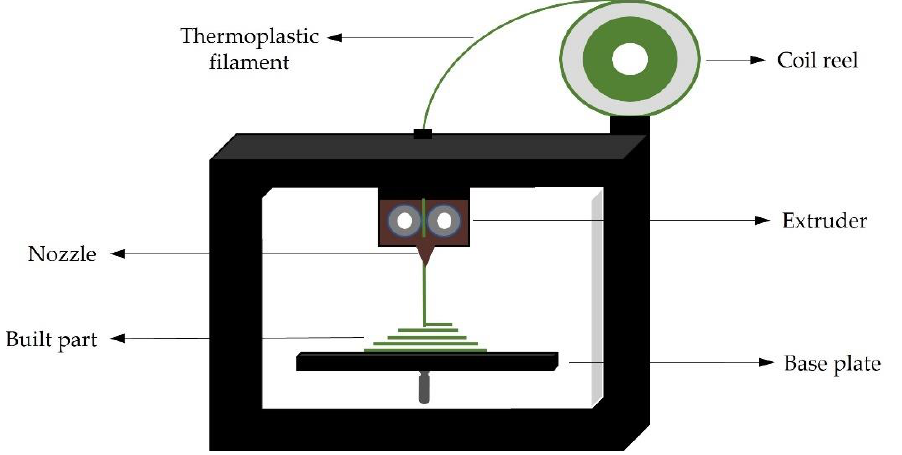
Figure 3. Simplified FDM 3DP schematic set-up.